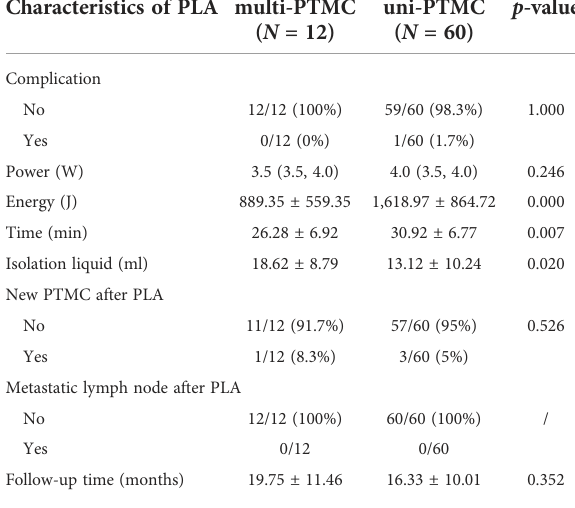
TABLE 2 Characteristics during and after PLA between the two groups. Characteristics of PLA multi-PTMC ( N = 12)